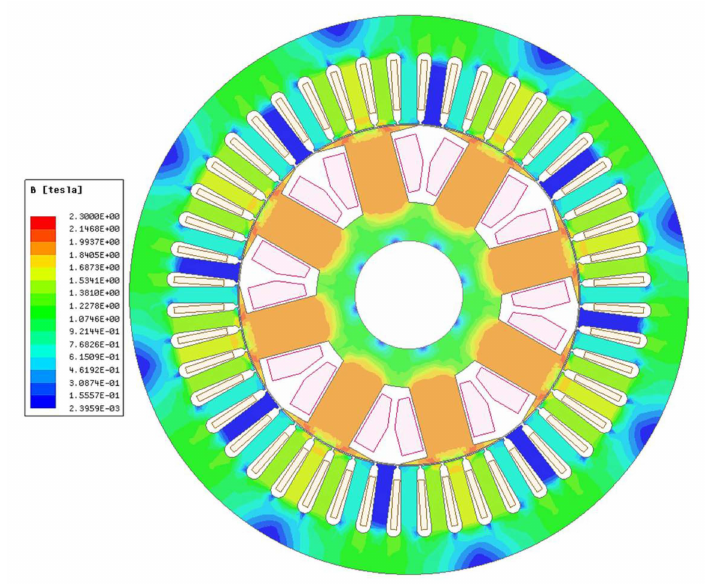
Figure 10. No load flux density plot of optimal model at rated speed.